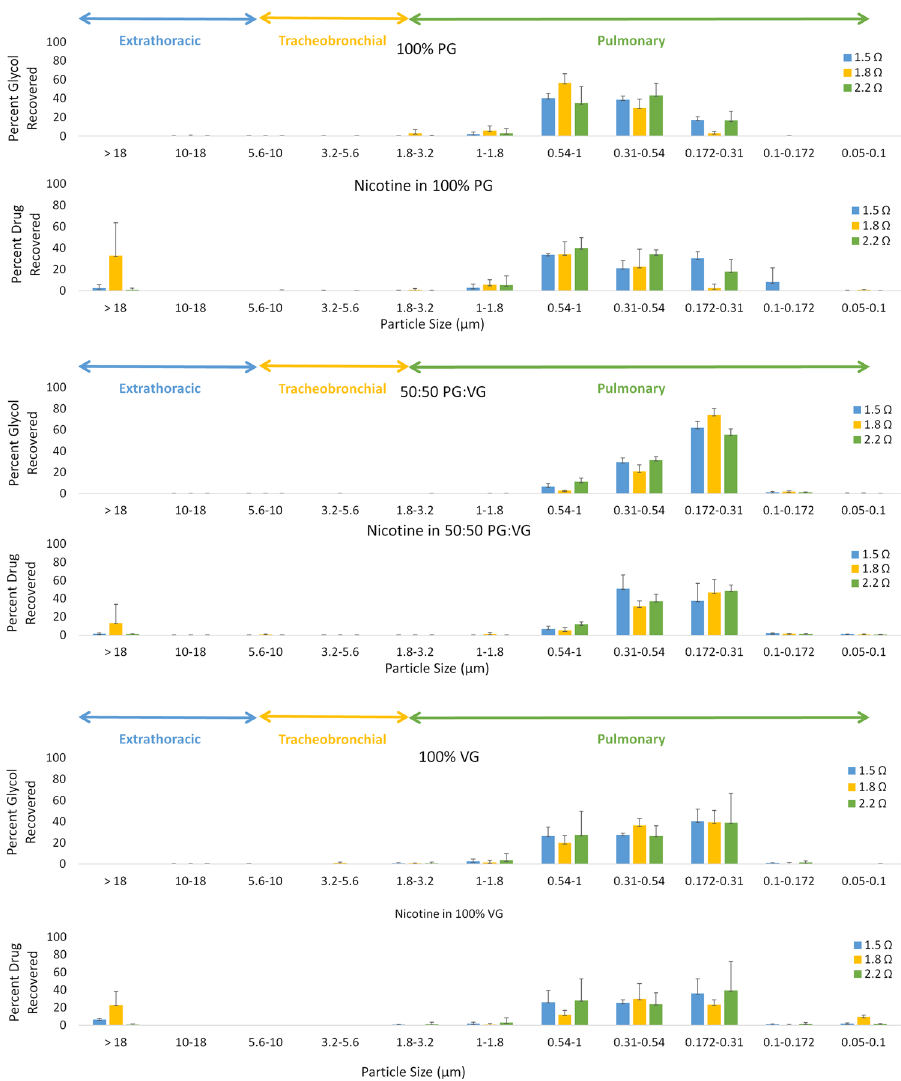
Figure 1. Particle size distribution of glycol and nicotine aerosol by glycol composition and voltage at 1.8